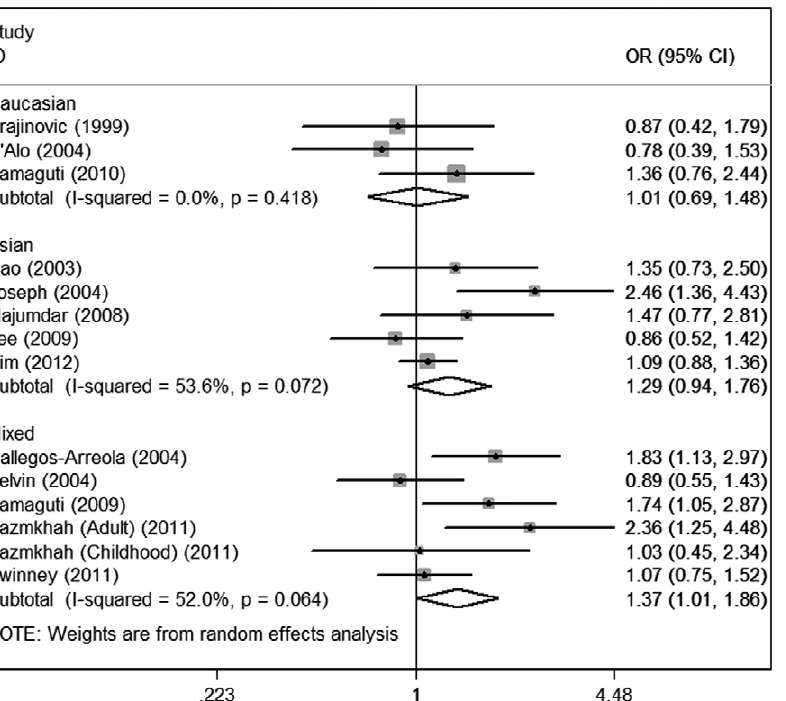
Figure 3. Meta-analysis for the association of acute leukemia risk with CYP1A1 Ile462Val polymorphism (Val/Val + Val/Ile versus Ile/ Ile; stratified by ethnicity).